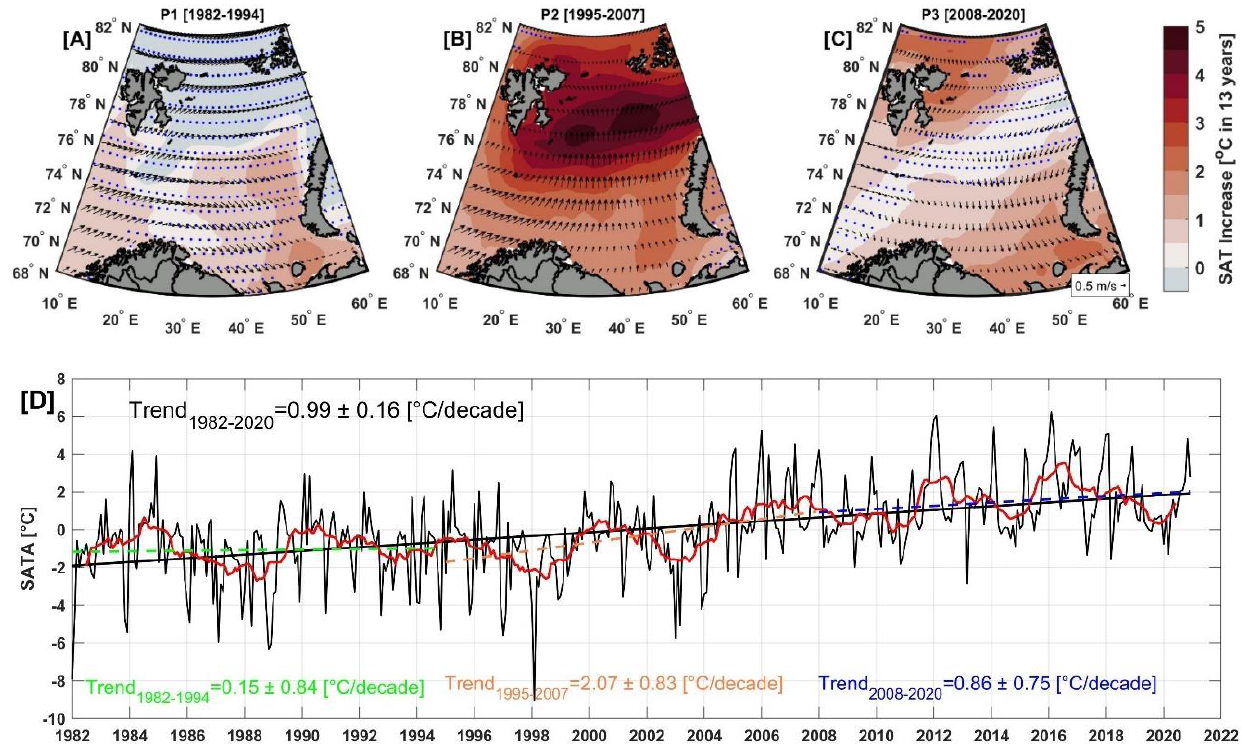
Figure 11. Spatial distribution of the de-seasoned trends of SATA for the periods; ( A ) P1 (1982–1994), ( B ) P2 (1995–2007), and ( C ) P3 (2008–2020), respectively. Regions where the SAT trends are not statistically significant at the 95% confidence interval (after Mann–Kendall’s test) are stippled. The vectors in the upper panels represent the corresponding trends (unit: (m/s)/13 years) of the surface winds. The reference for wind vectors trend is plotted in ( C ). ( D ) De-seasoned monthly mean time series of spatially averaged SATA over the whole Barents Sea from 1982 to 2020. Trends for each period (colored dashed lines) and for the entire period (black solid line) are also shown. To enhance the visualization and to emphasize interannual variability, the data was low-passed using a 13-month moving average (red line).